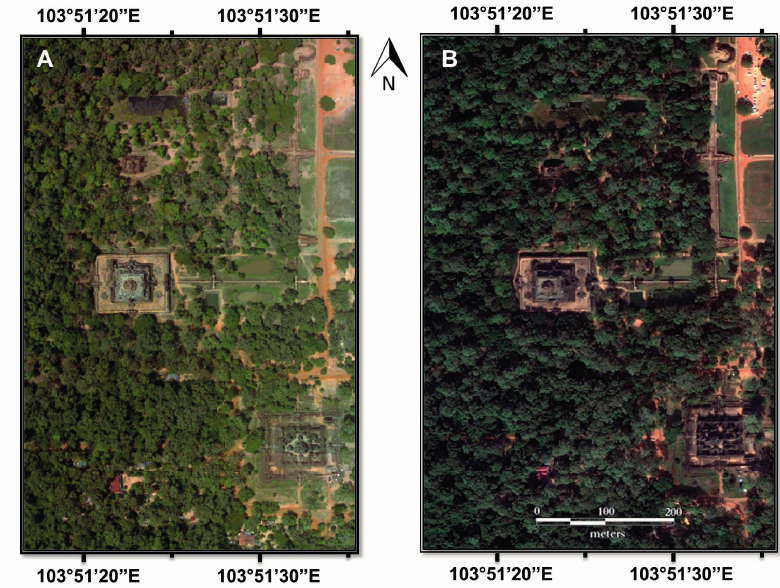
Figure 2. Aerial imagery used in the study: ( A ) Google Earth™ (GE) imagery and ( B ) very high-resolution (VHR) imagery (provided by Damian Evans) coverage over a portion of Angkor